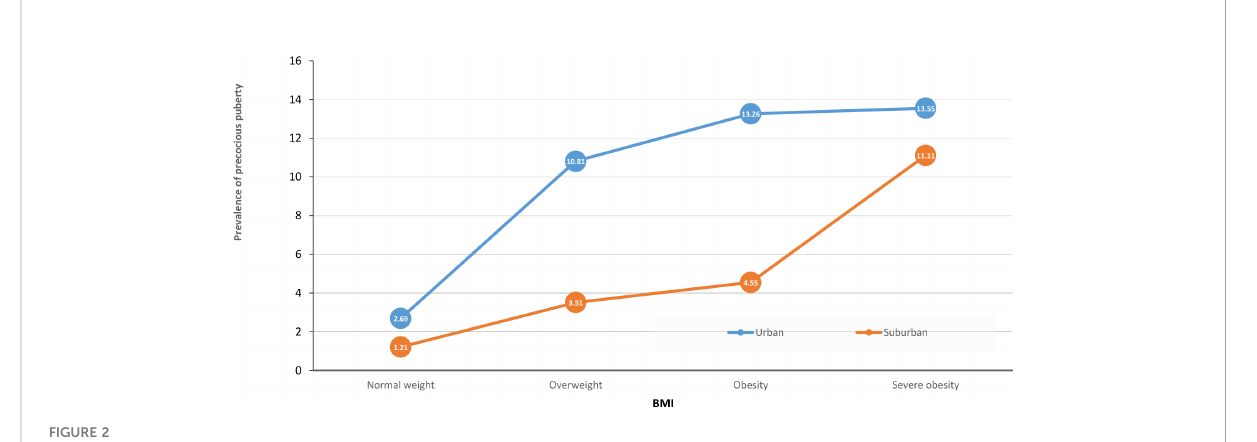
FIGURE 2 Relationship between the prevalence of precocious puberty and